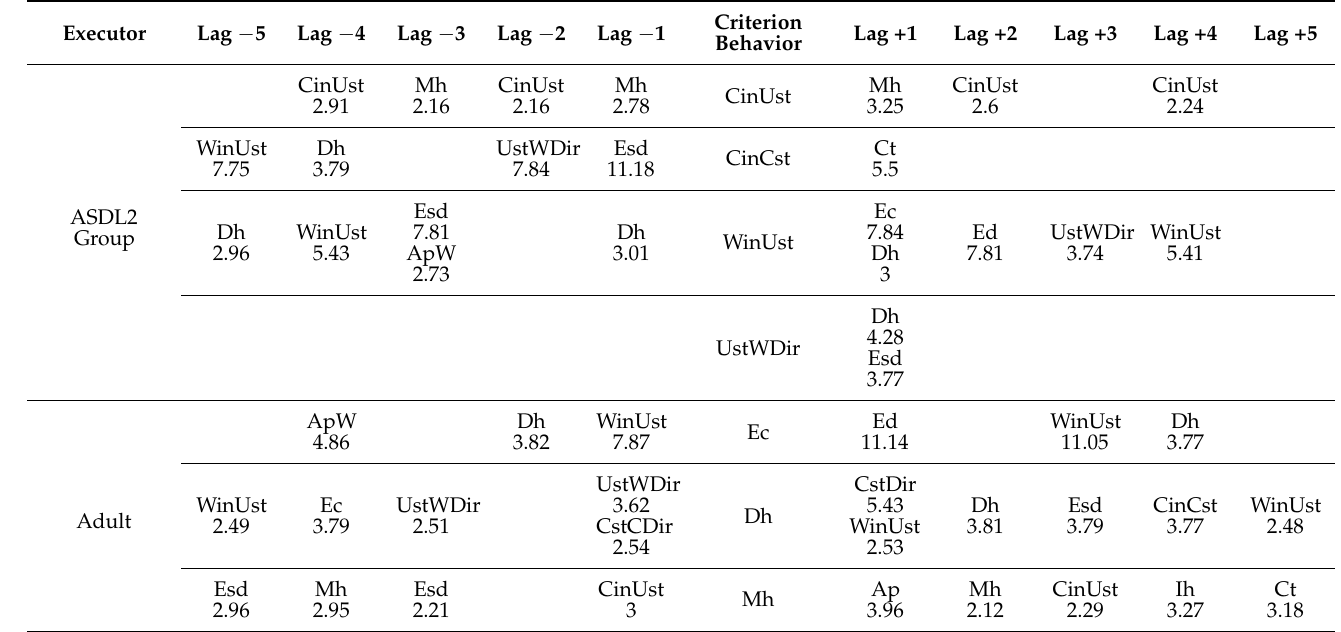
Table 8. Behavioral patterns obtained in the ASDL2 Group at the end of the intervention. Central column = It contains the criteria behaviors. Remaining cells = They contain the conditional behaviors. Numbers = Significant adjusted residuals values. Green codes = The most relevant behaviors indicating children progress in interference control. Red codes = The most relevant wrong interference control behaviors of the children. Blue codes = The most relevant adult scaffolding